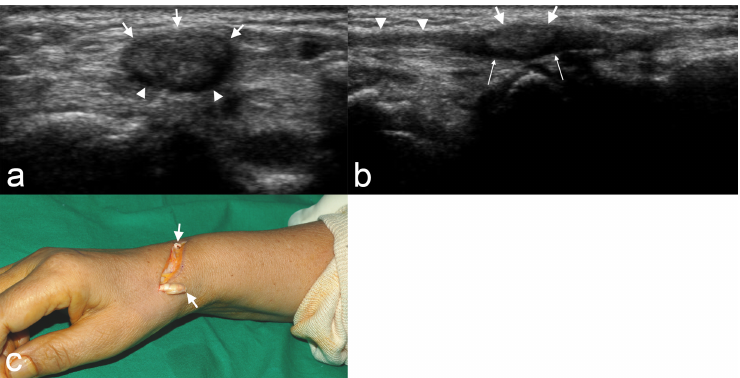
Fig 3. A 63-year-old woman with a rupture of the extensor pollicis longus tendon. (a) Ultrasound image of transverse scan shows pseudomass formation (arrows) that reveals an ovoid-shaped, heterogeneously hypoechoic lesion with a peripheral anechoic portion indicating fluid collection (arrowheads). (b) On ultrasound image of longitudinal scan, the extensor pollicis longus tendon shows decreased echogenicity at the ruptured tendon site (arrowheads). The ruptured tendon stump is seen as pseudomass formation (arrows) with surrounding anechoic portion indicating fluid collection (thin long arrows). (c) On surgery, the rupture of the extensor pollicis longus tendon was confirmed (arrows). Pseudomass formation was occupied with granulation tissue and hemorrhage